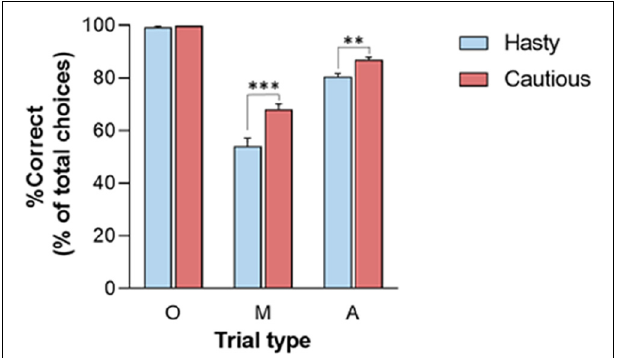
FIGURE 3 | CONTEXT × TRIAL_TYPE interaction on the percentage of correct choices (%Correct).%Correct was lower in the hasty (blue bars) than in the cautious (red bars) context when considering Misleading (M) and Ambiguous (A) trials but not for the Obvious (O) trials. Note the absence of errors in these latter trials (%Correct = 100), whether in the hasty or cautious context. ∗∗ p < 0.01, ∗∗∗ p < 0.001: significantly different.